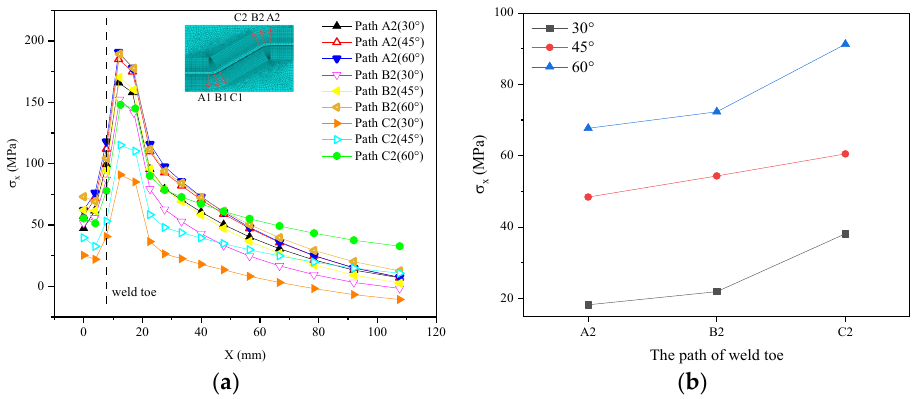
Figure 20. Residual stress distribution of transverse path front weldment. ( a ) Along the path direction; ( b ) Position of weld toe.